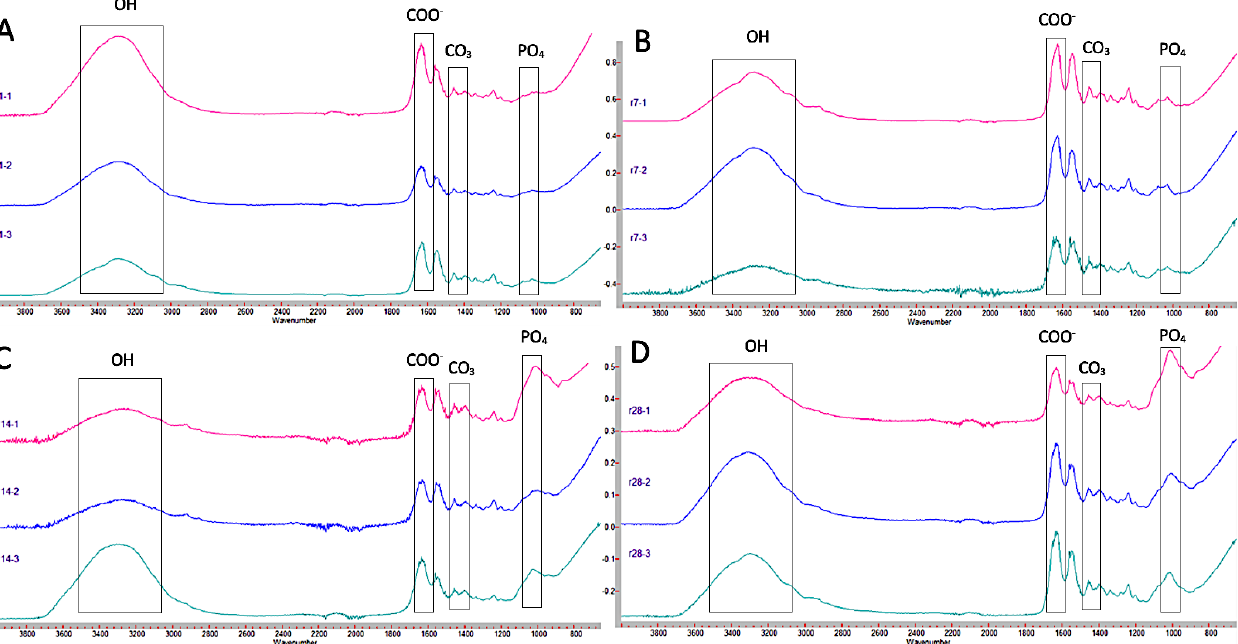
Figure 6. Comparison of Riva Light Cure FTIR spectra at different thicknesses (1, 2, and 3 mm) at 24 h ( A ), 7 days ( B ), 14 days ( C ), and 28 days ( D ). The peaks of the OH, COO − , CO 3 , and PO 4 groups of interest in this study are indicated.